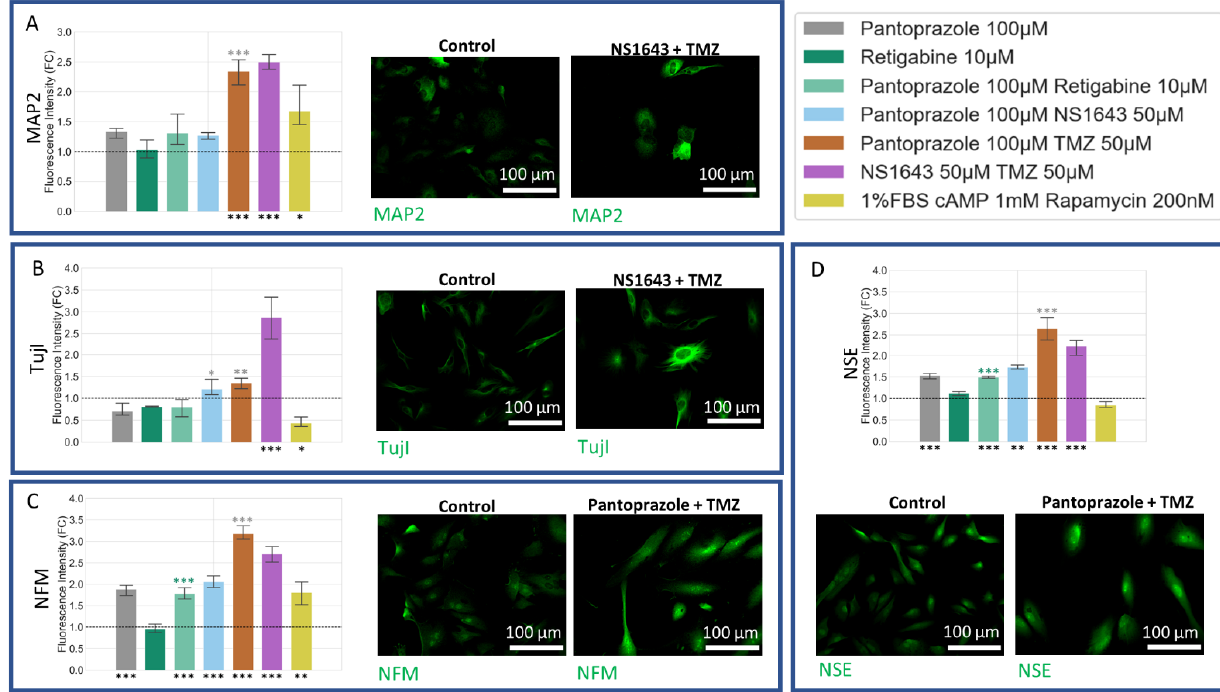
Figure 11. Differentiation Analysis of U87 Cells Reveals that Treatments with Pantoprazole Increased Neuronal Markers after 6 days. Immunofluorescence of cells was conducted and analyzed with CellProfiler for integrated fluorescence intensity. ( A ) Stain of Microtubule Associated Protein 2 (MAP2). ( B ) Stain of Neuron-Specific Class III β -Tubulin (TujI). ( C ) Stain of Neural Filament Medium Chain (NFM). ( D ) Stain of Neuron-Specific Enolase (NSE). Treatments corresponding to the colored bars are outlined in the figure itself. The log of the fold change in intensity was compared between single treatments and combined treatments, except the positive control, with significant values shown in the color of the treatment compared. The initial fluorescence intensities were compared to their corresponding control, with significant values shown under the bars as, ***: p < 0.001, **: p < 0.01, * : p < 0.05 (one-way ANOVA with Tukey post hoc analysis n > 3 technical replicates).